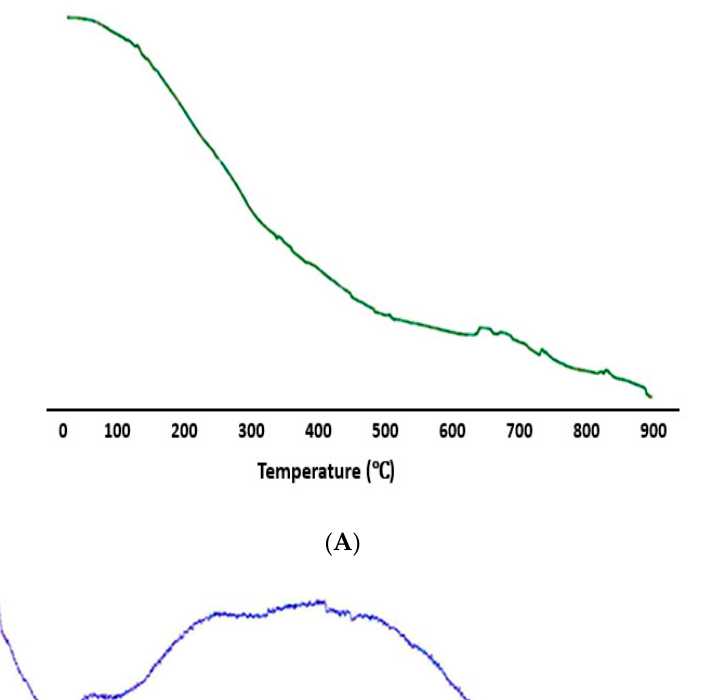
Figure 5. Fourier transform infrared (FTIR) spectra of P. hysterphorus leaf extract ( A ) and optimized PrSNPs ( B ).